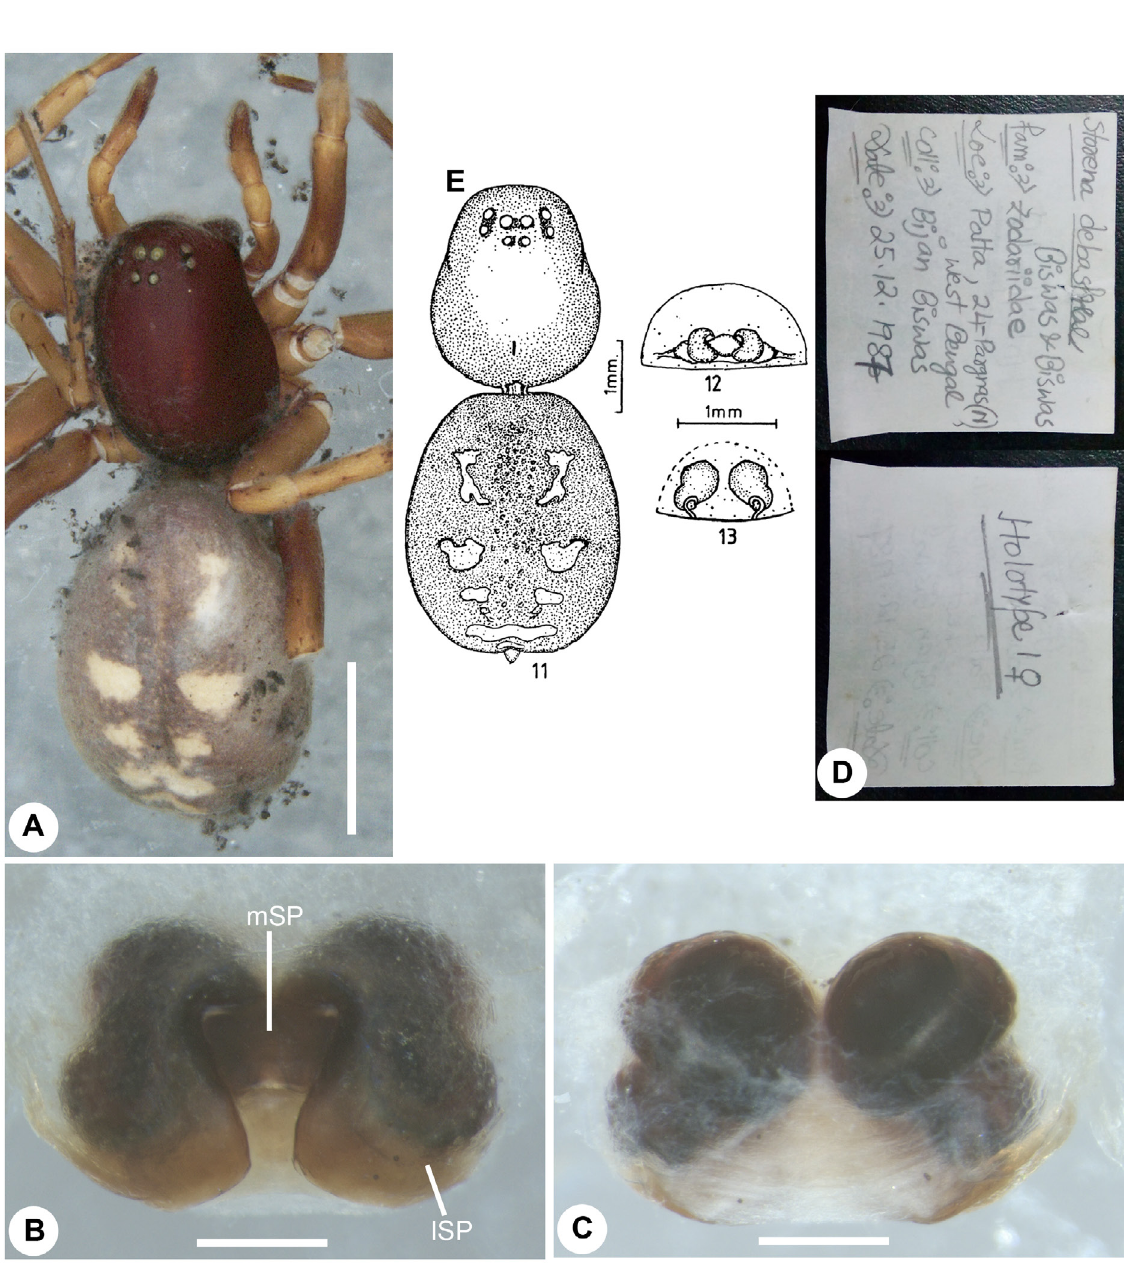
Fig. 6. Laminion debasrae (Biswas & Biswas, 1992) gen. et comb. nov., ♀, holotype of Storena debasrae Biswas & Biswas, 1992 (NZC-ZSI-5411/18). A . Female habitus, dorso-lateral view. B . Epigynum of the same, ventral view. C . Vulva of the same, dorsal view. D . Type label. E . Original illustrations of S. debasrae adapted from Biswas & Biswas (1992). Abbreviations: lSP = lateral sclerotised plate; mSP = median sclerotised plate. Scale bars: A = 2 mm; B–C = 0.2